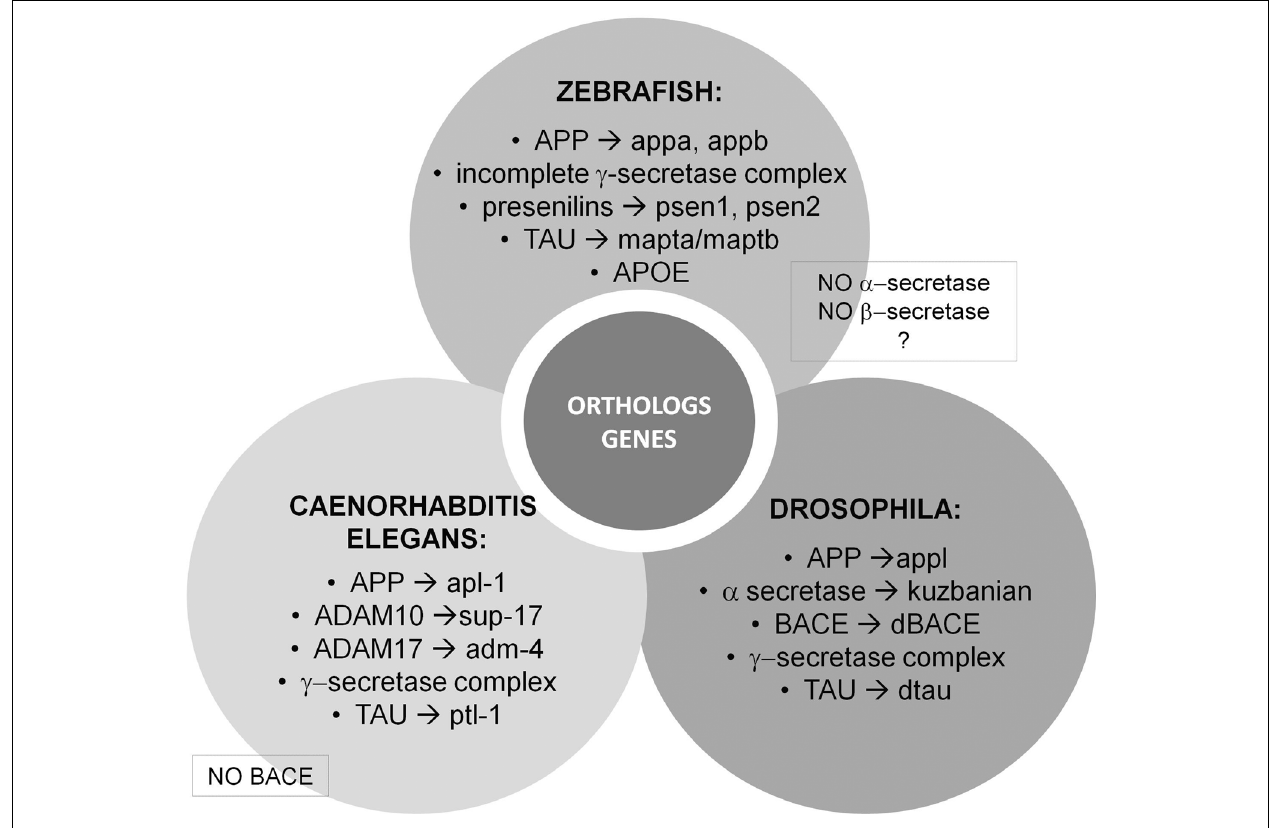
FIGURE 2 |Vertebrate and invertebrate orthologs genes. Most of the proteins associated with AD are evolutionarily conserved in Drosophila and Caenorhabditis elegans making these organisms attractive model systems to